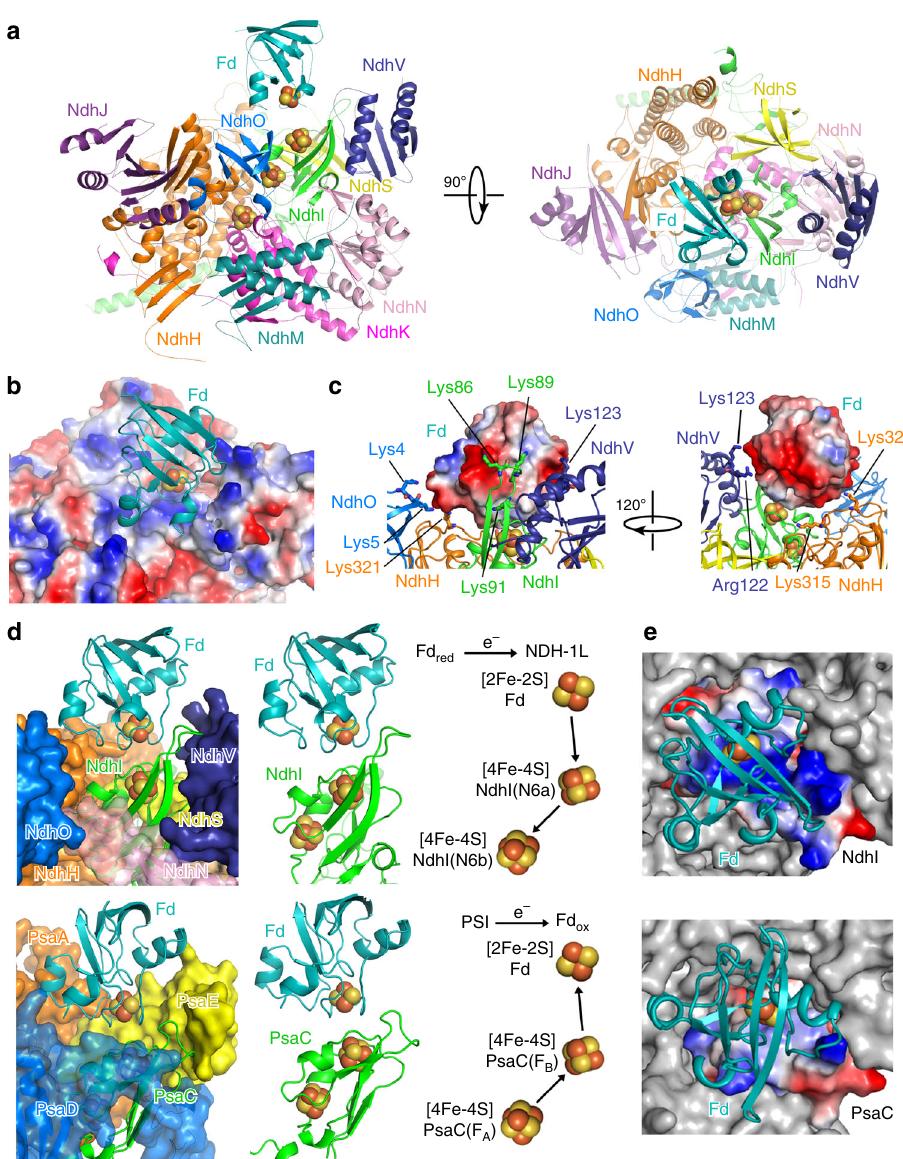
Fig. 3 The Fd-binding pocket of NDH-1L. a Two orthogonal views of the peripheral arm of NDH-1L in complex with Fd. Proteins are colored as in Fig. 1b and ion-sulfur clusters are shown as spheres. b Electrostatic surface potential of the Fd-binding pocket at the peripheral arm of the NDH-1L complex (positive potential, blue; negative potential, red). Fd is presented in cartoon model and colored in teal. c Close-up views of key Fd-interacting residues of NdhI, NdhH, NdhV, and NdhO. d The Fd-binding pocket of NDH-1L highly resembles that of PSI (left). Fd binds to NdhI in a similar manner as Fd to PsaC (middle). The distance and angular relationships between the [2Fe-2S] cluster in Fd and [4Fe-4S] clusters in NDH-1L and PSI (right). Arrows indicate the direction of electron fl ow. e The overall electrostatic surface potential of the Fd-binding pockets is highly positive in NDH-1L and close to neutral in